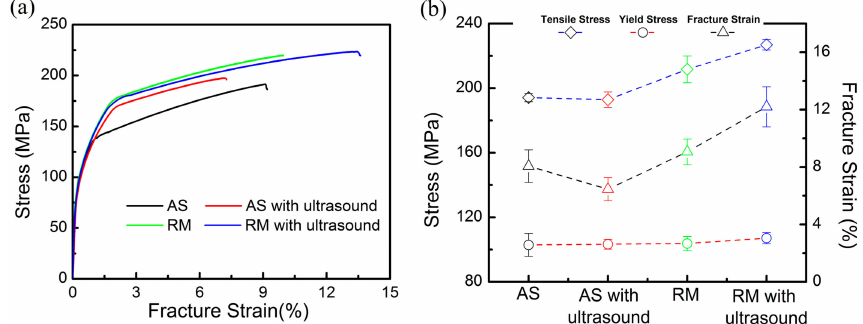
Figure 8. Curves of tensile samples manufactured with the four di ff erent processes: ( a ) Tensile stress-strain curves; ( b ) Tensile